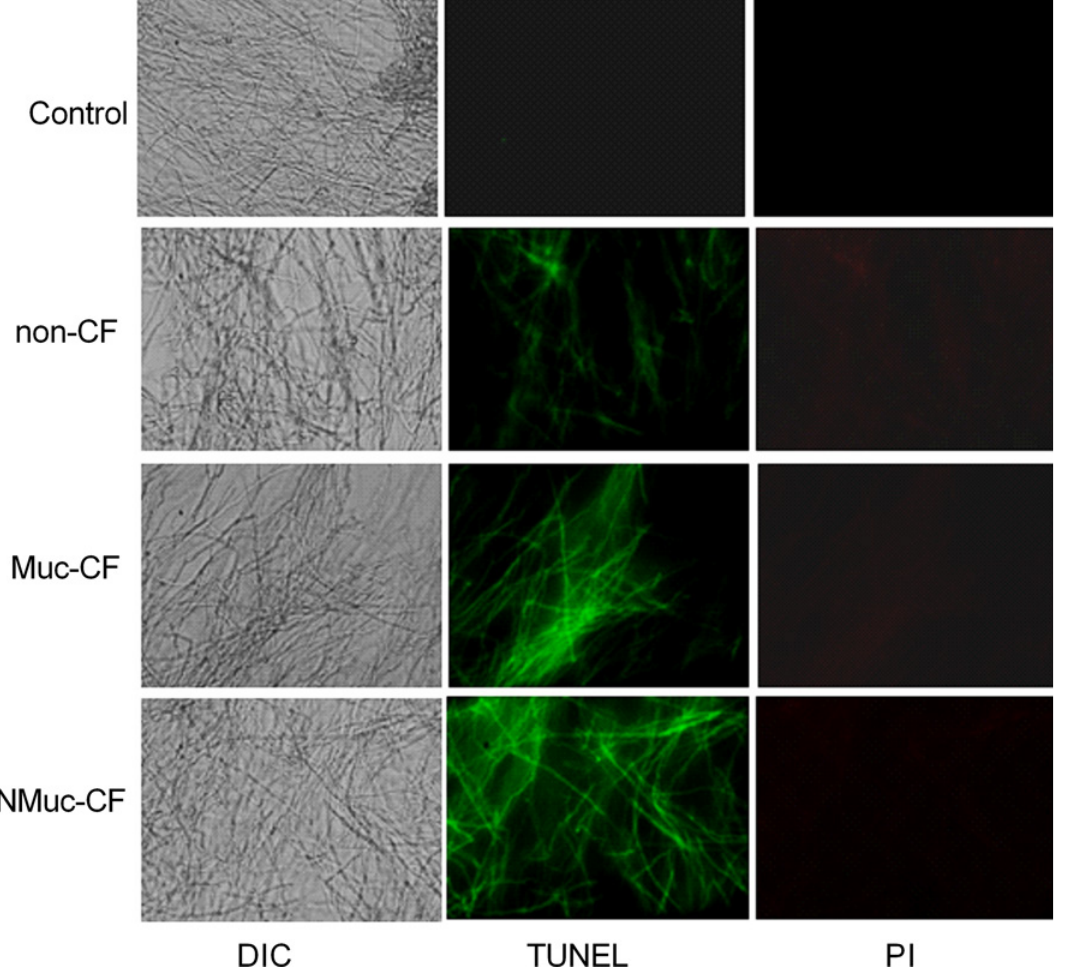
Fig 3. Culture filtrates of P . aeruginosa leads to DNA fragmentation and membrane disruption in preformed A . fumigatus biofilms, as shown by TUNEL assay and membrane integrity by propidium staining (PI). Fluorescence images of DNA fragmentation of preformed A . fumigatus biofilms treated with biofilm culture filtrates of non-CF, Muc-CF, and NMuc-CF P . aeruginosa . DIC: differential interference contrast.